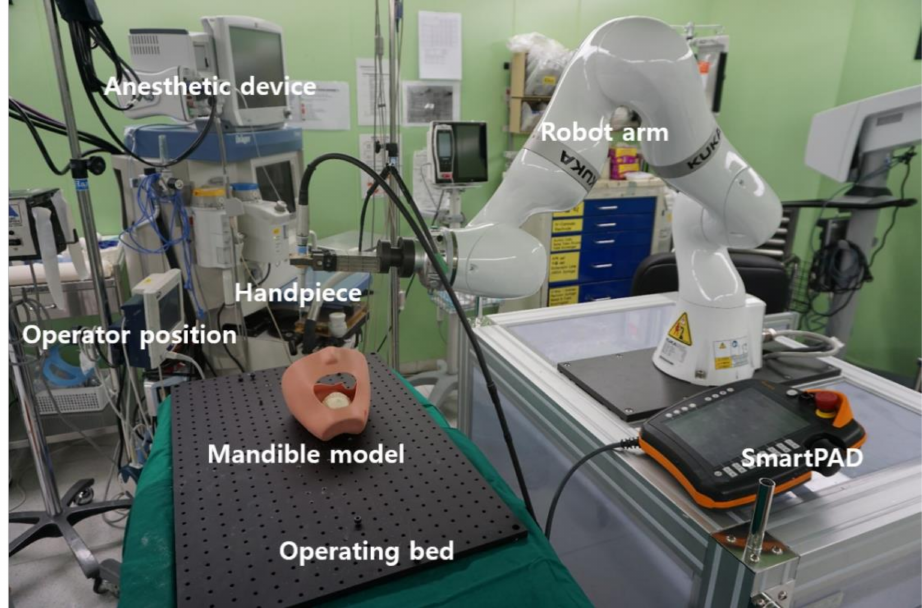
Figure 1. Overview of our autonomous robot osteotomy system. The robot consisted of four parts: (a) Workbench notebook, (b) Robot controller (cabinet), (c) Robot arm, (d) SmartPAD ®